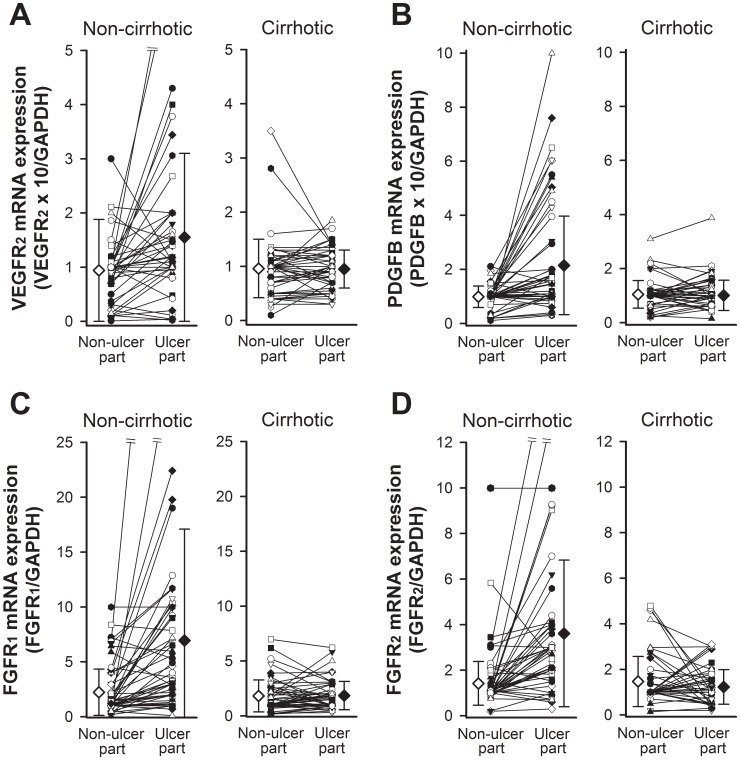
Significant elevation of the mRNA expressions of PDGFB, VEGFR2, FGFR1, and FGFR2 in the ulcer margin was noted compared to the non-ulcer areas (p<0.05) in the non-cirrhotic group, but not in the cirrhotic group.